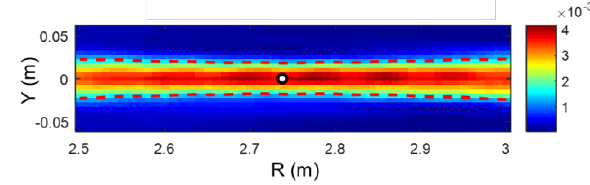
Fig. 10. Beam pattern (vertical direction) along the major radius. The white spot shows the position of the focal plane.